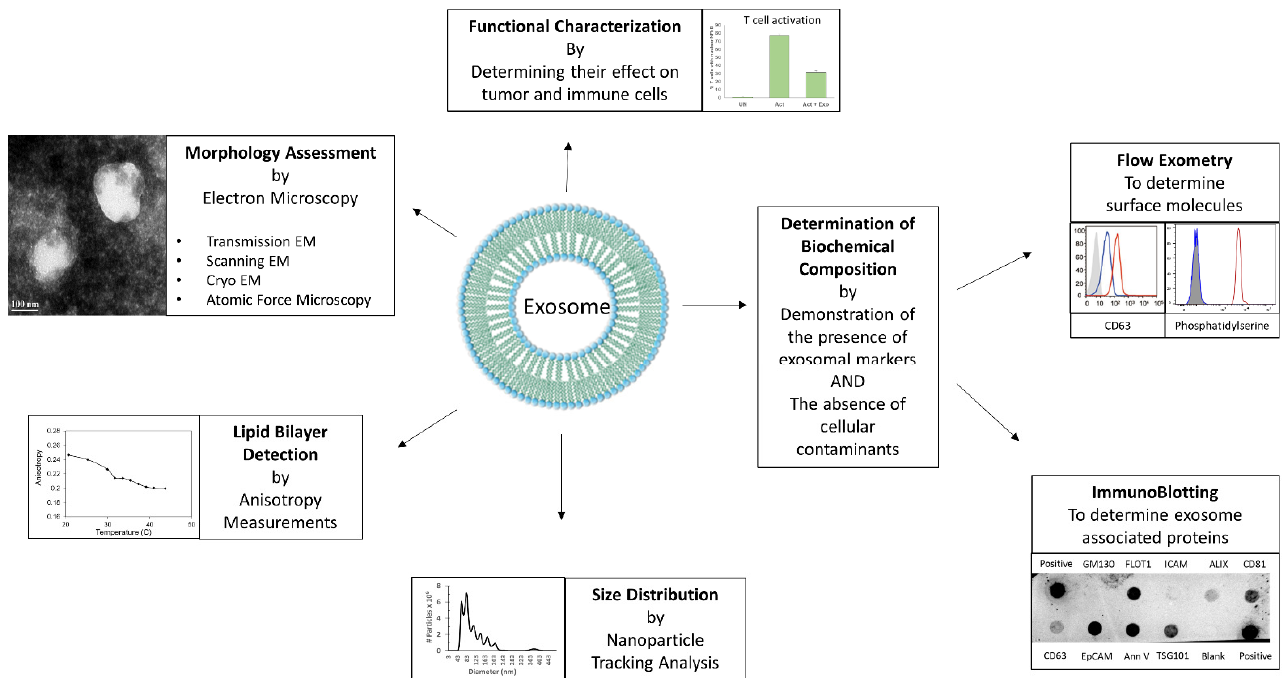
Figure 1. Characterization of Exosomes. The different parameters and methods utilized for characterizing exosomes, such as morphology assessment by electron microscopy, lipid bilayer detection by anisotropy measurement, size distribution by nanoparticle tracking analysis (NTA), determination of biochemical composition by flow exometry and/or immunoblotting, are depicted. Representative data shown are either reused from previously published article by the authors [8], or unpublished original data.